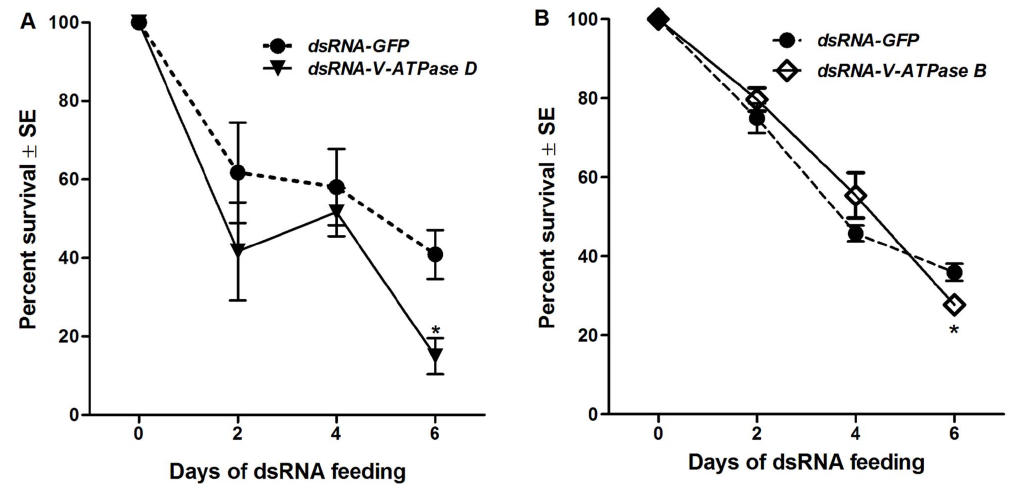
Figure 3. Peregrinusmaidis mortality after ingestion of dsRNA. The proportion of live 3 rd -stage nymphs was determined at 2-day intervals after feeding with artificial diet containing 500 ng/uL dsRNA of V-ATPase D , dsRNA of V-ATPase B or dsRNA of GFP as a negative control for up to six days. Each point represents the mean 6 the standard error of the mean of n = three biological replicates, i.e. , independent trials, with groups of 30 insects permanently removed from the experiment to assess mortality at each time point. The asterisk (*) indicates that treatment ( A : dsRNA of GFP and V-ATPase D, B : dsRNA of GFP and V-ATPase B ) means differ significantly ( P , 0.05) at a given time-point.